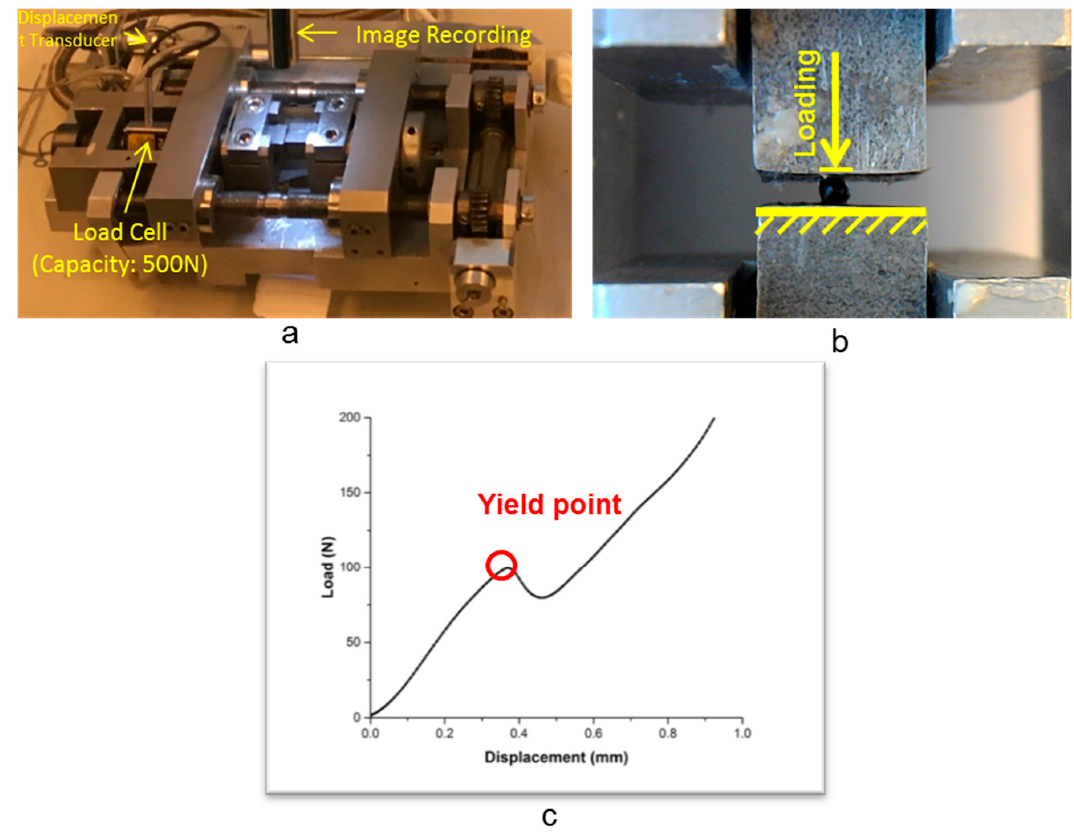
Figure 3. Compressive test on calcium alginate capsules using tensile strength testing machine (TSTM): ( a ) TSTM testing setup; ( b ) a capsule sample during compression; and ( c ) a load and displacement curve from compressive test.